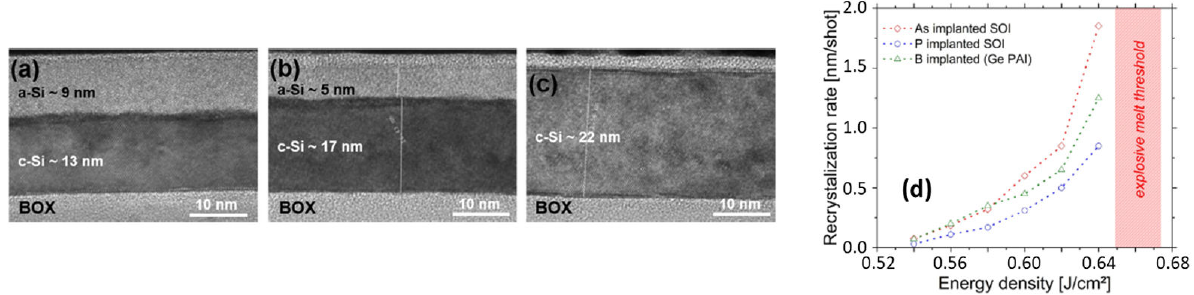
Figure 10. ( a – c ) Progressive SPER with ns UV-LA multiple pulses in a structure of amorphous Si/SiO 2 /Si substrate. ( d ) Estimated recrystallization rates for each sample as a function of laser energy density. Reprinted/adapted under CC BY 4.0 from Ref. [46]. 2021, P. Acosta Alba et